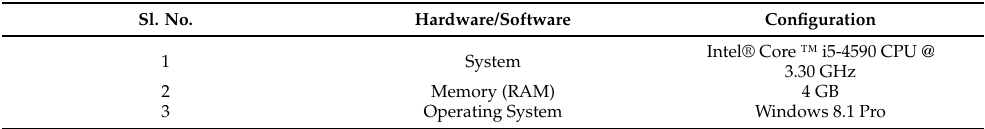
Table 4. Hardware/software